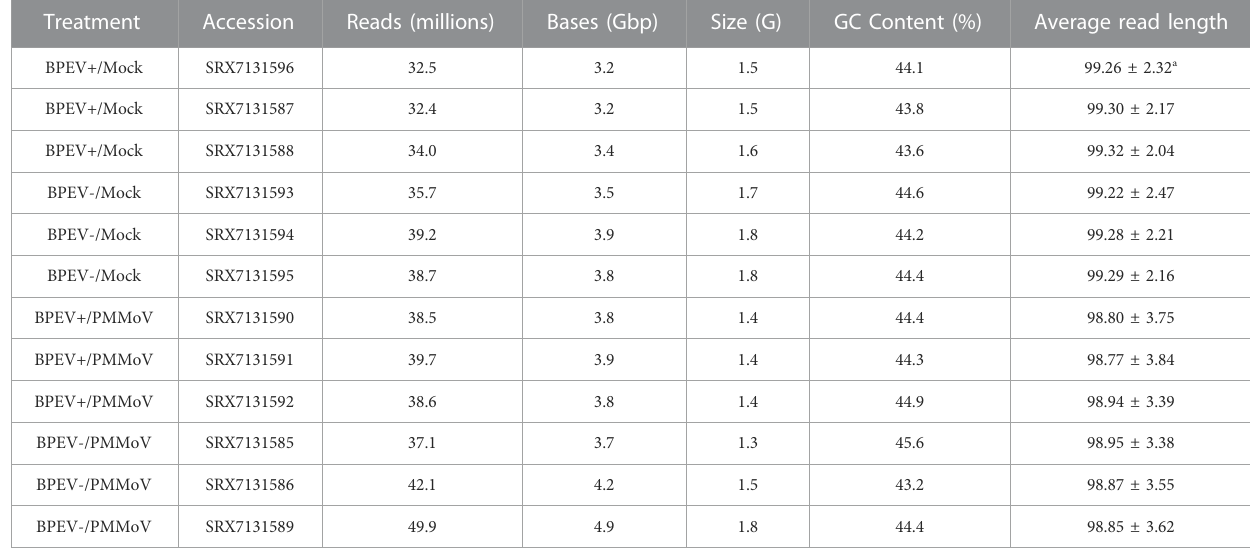
TABLE 1 Treatments and summary statistics of RNA-seq data. BPEV = bell pepper endornavirus, and PMMoV = pepper mild mottle virus. The “ + ” or “ - “ symbols indicate infected or free of BPEV, respectively.